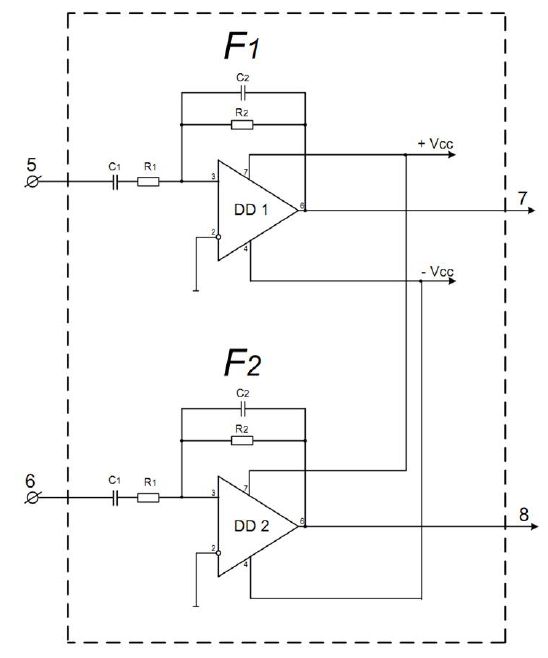
Figure 12. Logical Part of